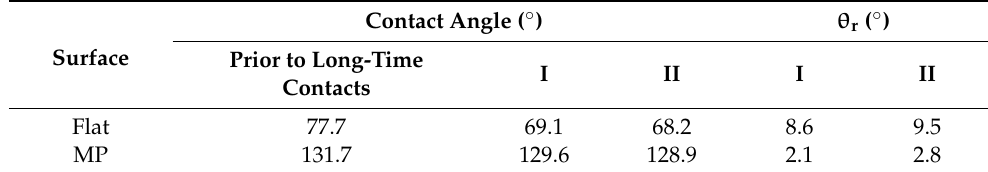
Table 1. Water contact angles (CA) of the flat surface [1] and micropillar surface (MP) prior to and (I) after intermittent contact and (II) after continuous contact with NaCl solution. θ r values ( θ r = contact angle prior to long-time exposure—contact angle after long-time exposure) of the flat surface [1] and MP: (I) after intermittent contact and (II) after continuous contact with NaCl